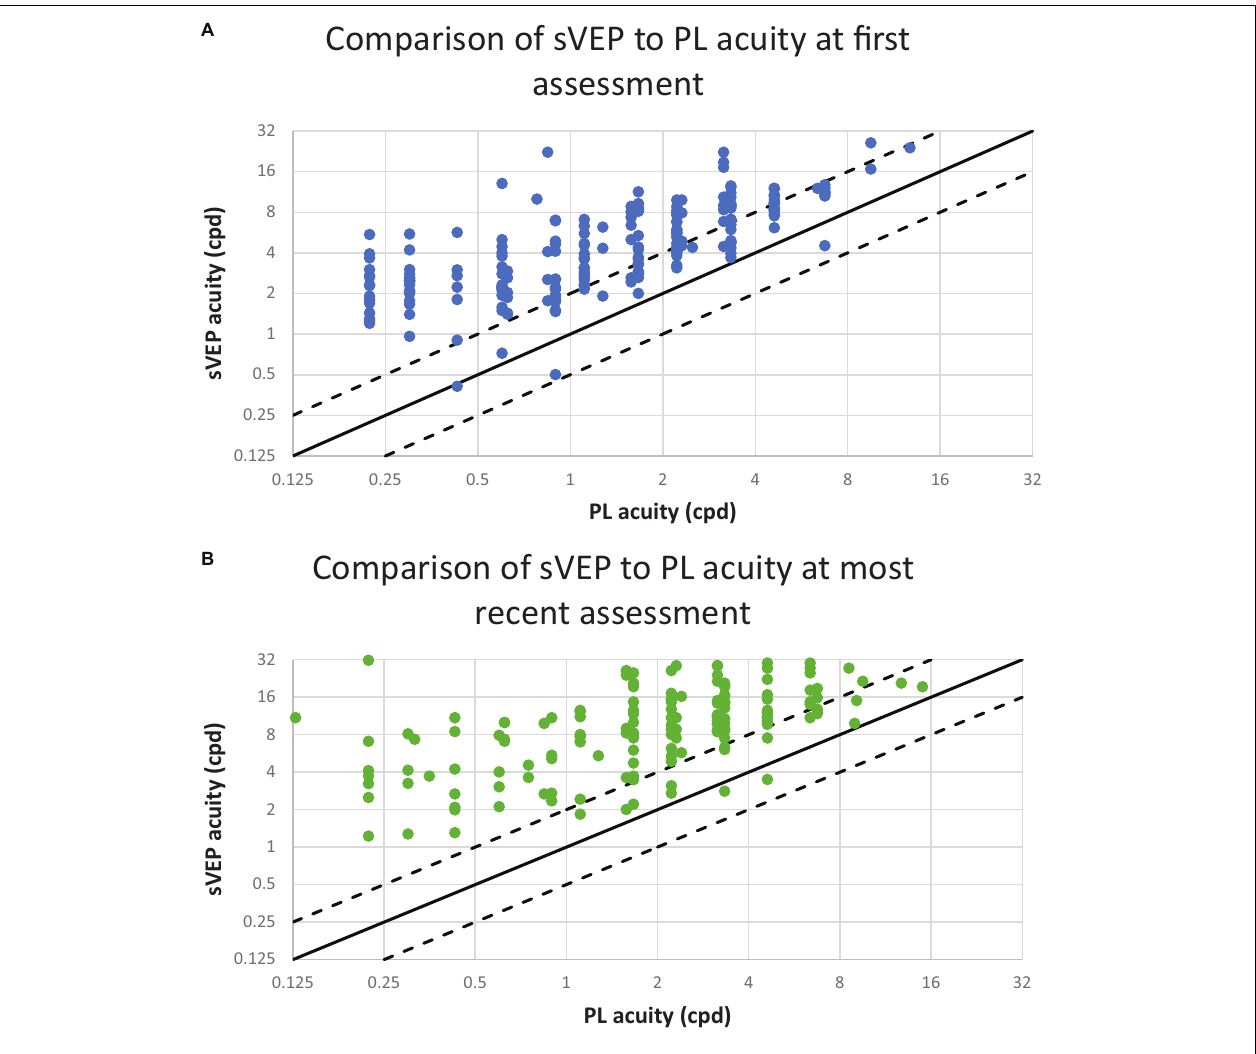
FIGURE 2 | The relationship between preferential looking (PL) and visual evoked potential (VEP) acuities. Each point represents one patient. The diagonal lines have a slope of 1.0. The solid line represents PL and sVEP acuity values in perfect agreement. The dashed lines 1 octave above and below the solid line. The ordinate and the abscissa are a log 2 scale; cpd indicates cycles per degree. (A) Visual acuity assessments conducted at the patient’s first visit. The results from 225 patients are plotted. (B) Visual acuity assessments conducted at the patient’s most recent visit. The results from 156 patients are